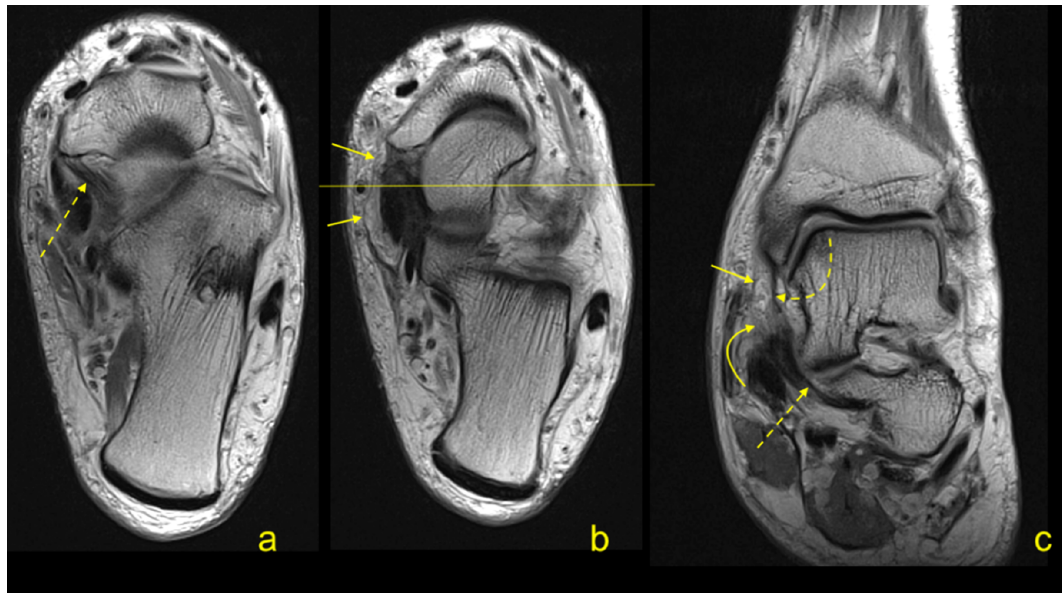
Figure 7. ( a – c )—a 51-year-old patient after kidney transplantation with clinical suspicion of avascular necrosis of the talus. ( a , b )—PD weighted images. FR (straight arrow) gives projection (curved arrow) to communicate with SL (dashed arrow). Deeply to FR (straight arrow), TNP (curved dashed arrow) is present.